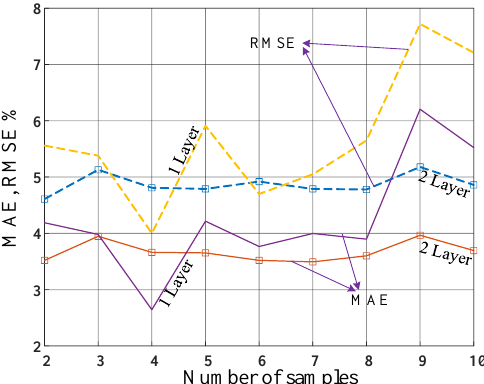
Figure 4. The obtained errors of the applied ANN models with different structures. The obtained errors are calculated by the 10 times running of each network with defined numbers of neurons and hidden layers. Also, the errors are calculated using normalized data, and the networks with 1 hidden layer and 2 hidden layers are applied. Figure 5 shows the proposed MLP structure for the defined artificial network. Ac- cording to this figure, the input parameters are connected to the output nodes by a single hidden layer including four neurons in the hidden layer. After finding the best structure, the proposed ANN model is tested 100 times with the epochs of 200 up to 1000, to obtain the best values of the proposed ANN model.